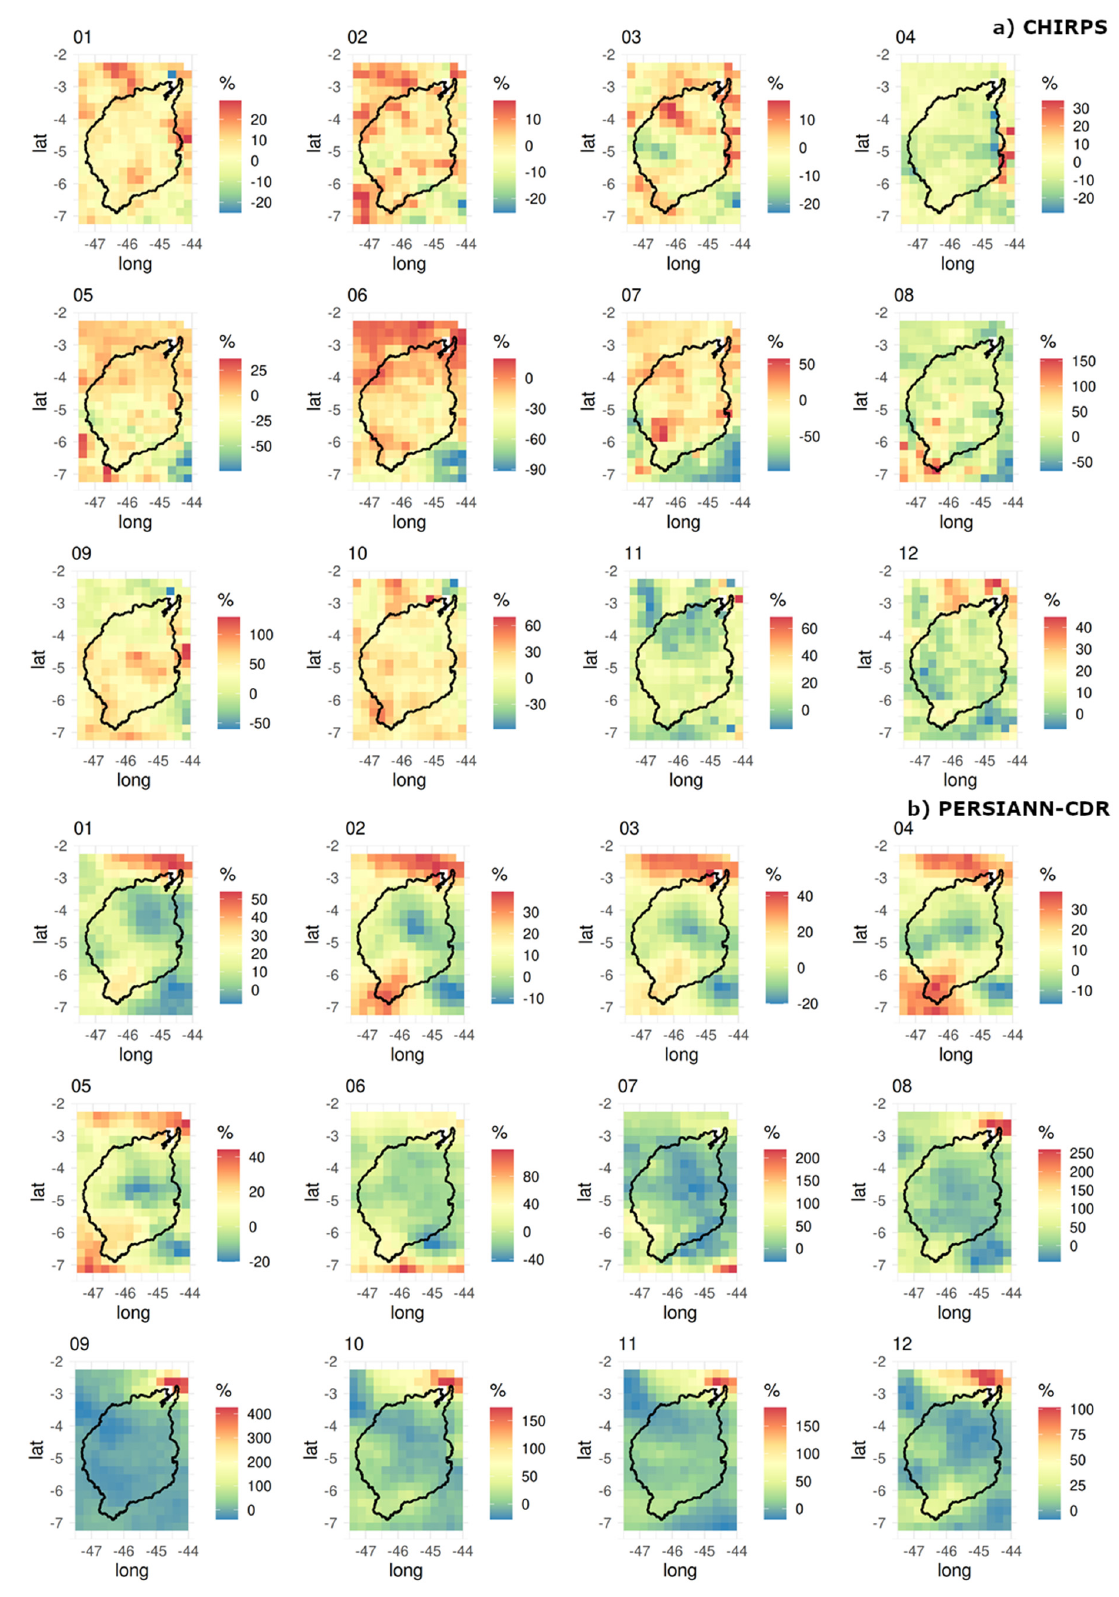
Figure 6. Mean monthly pbias (%) (gridBR × CHIRPS ( a ) and gridBR × PERSIANN-CDR ( b )) from January (01) to December (12) 1983 to 2013. Each SRE and each month for pbias (%) have different representative scales.